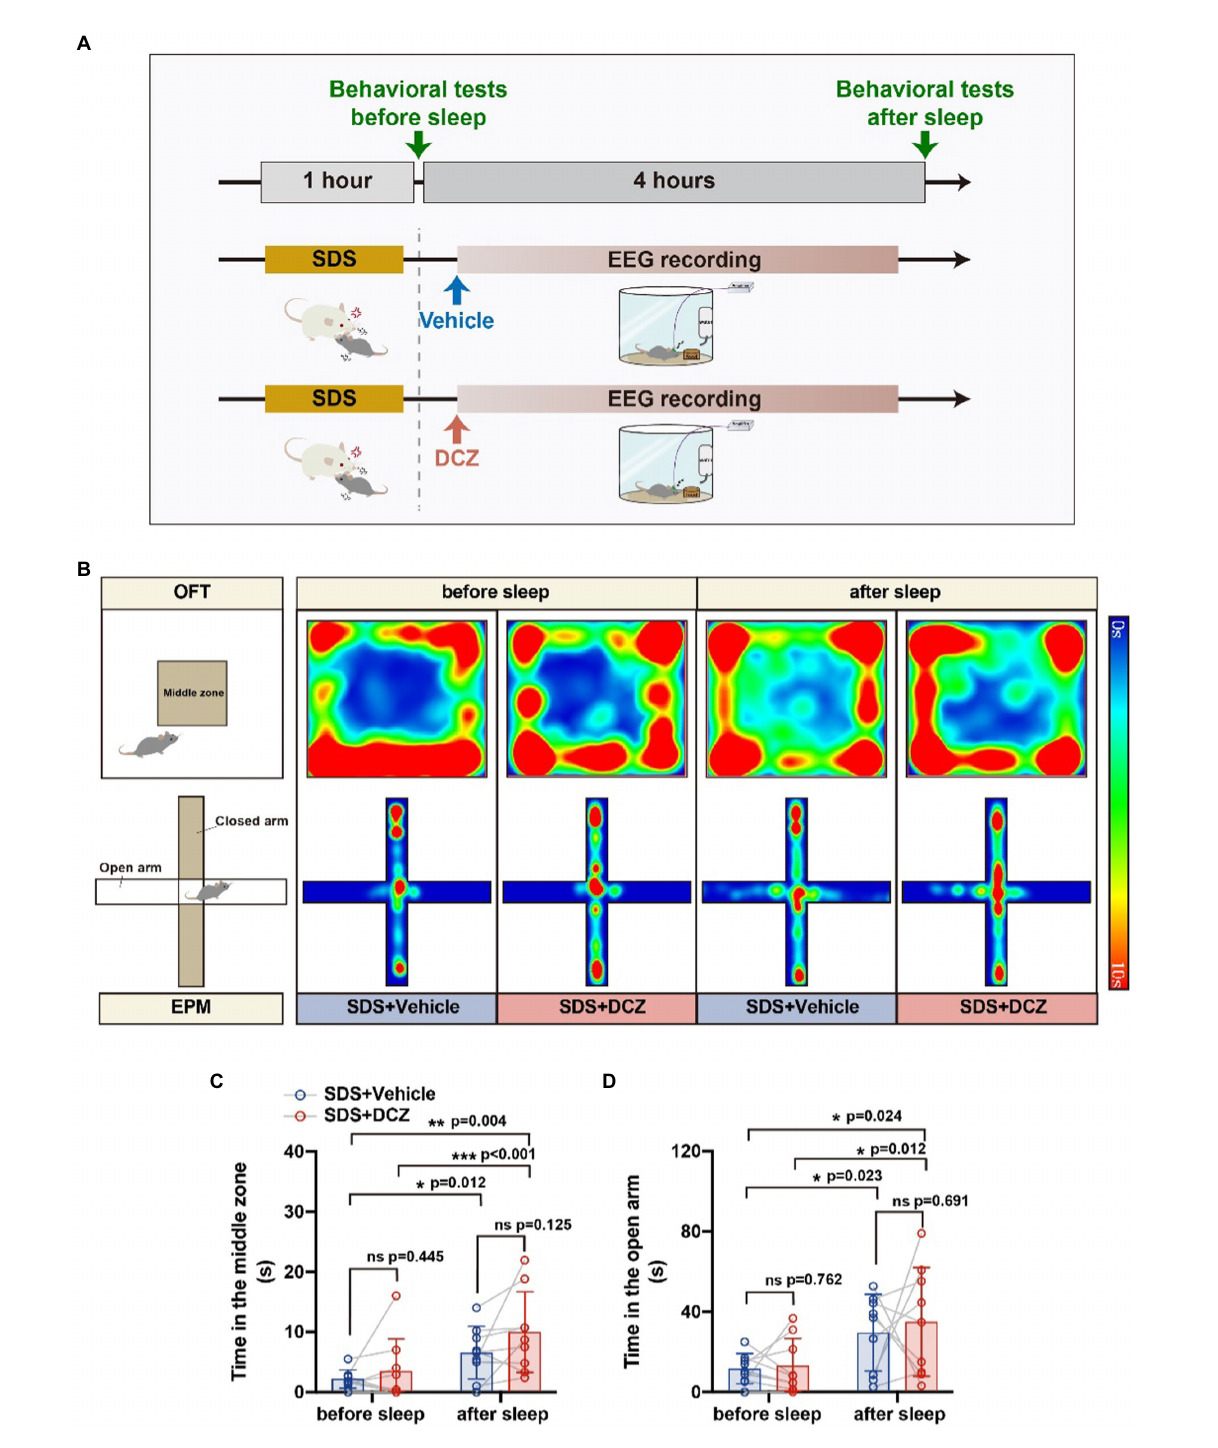
FIGURE 6 Activation of VTA Vgat neurons further relieved stress in APP/PS1 mice. (A) Schematic diagram of SDS + VTA Vgat vehicle or SDS + VTA Vgat activation round. (B) Representative heatmaps of trajectories in OFT and EPM before and after EEG recording in SDS + VTA Vgat vehicle or SDS + VTA Vgat activation round. (C,D) Quantitative analysis of OFT and EPM in SDS + VTA Vgat vehicle or SDS + VTA Vgat activation round. n = 9, paired t